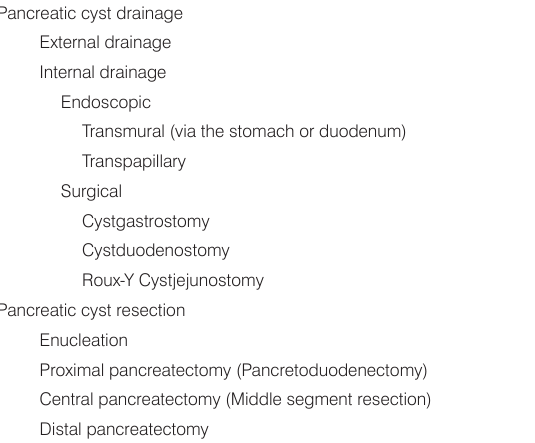
Table 5. Types of the treatment in pancreatic